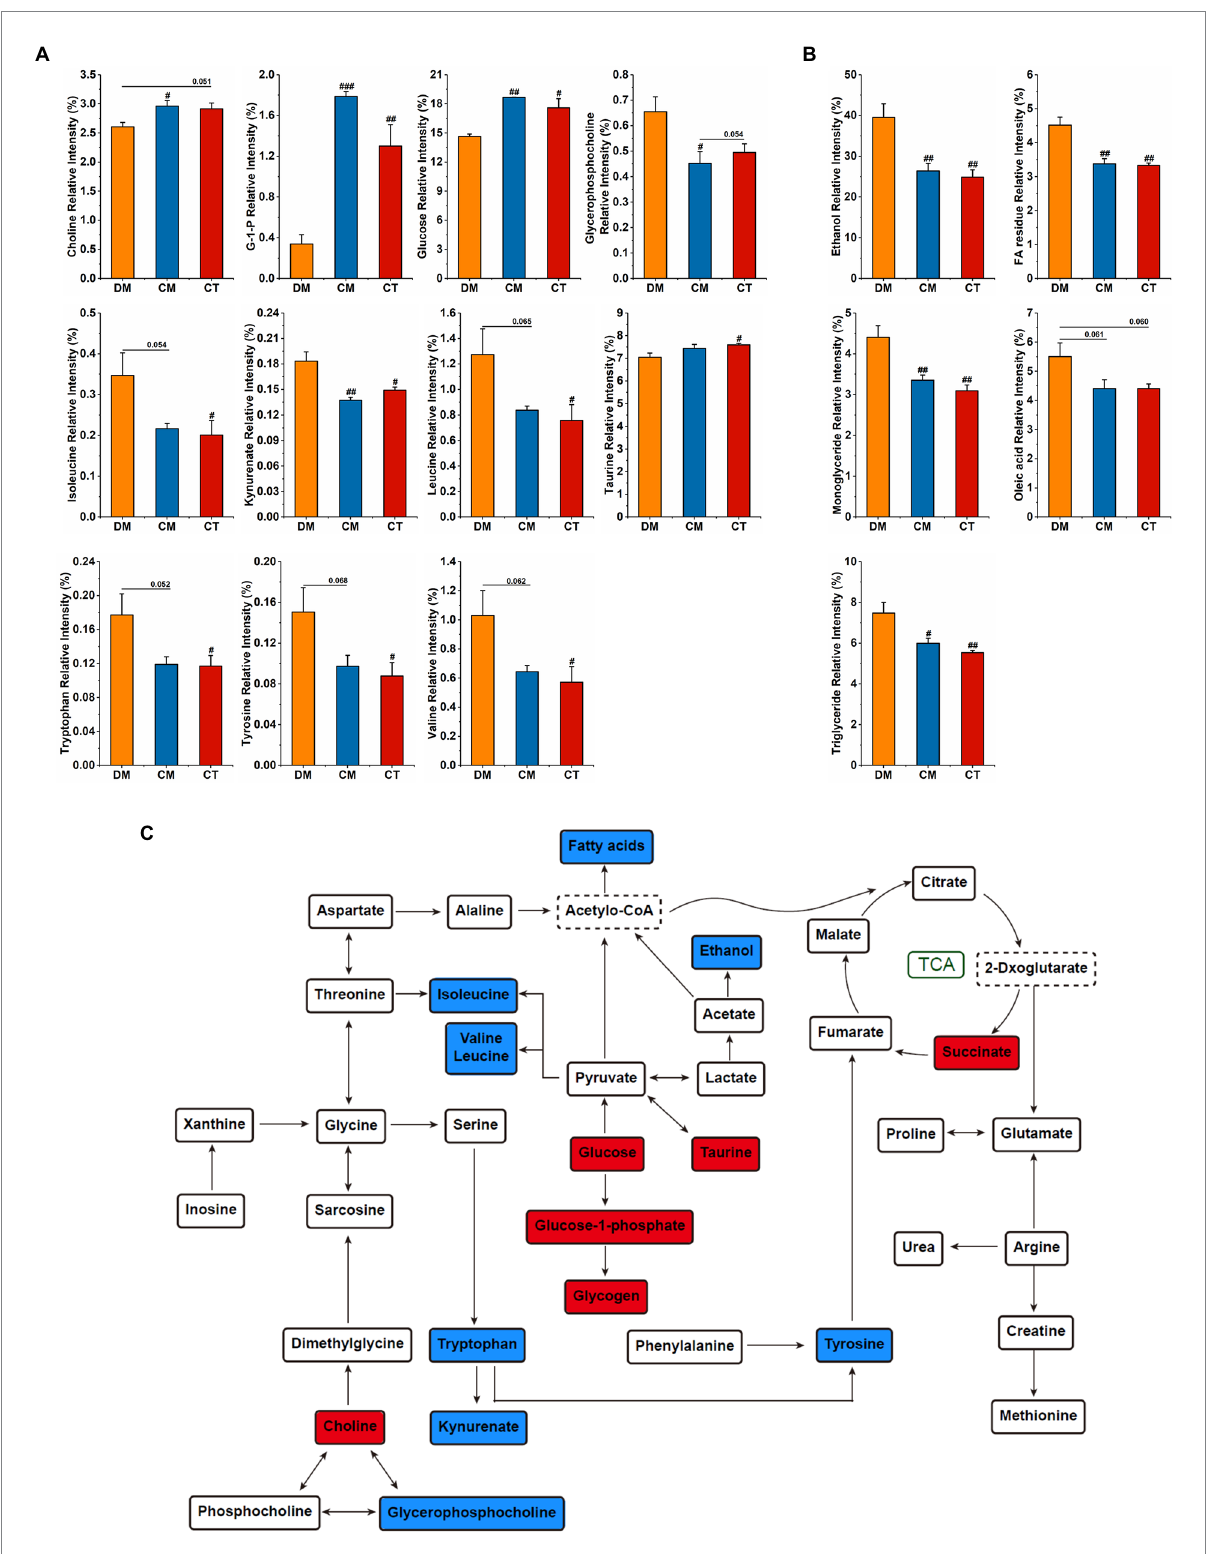
FIGURE 6 Supplementation with Christensenella affected liver metabolism. (A) Significant changes of relative intensity of hydrophilic metabolites. (B) Significant changes of relative intensity of lipophilic metabolites. (C) Main metabolite pathways of the liver of diabetic mice treated by Christensenella . The red/blue fillers indicate that the metabolite content increased/decreased after Christensenella treatment compared with the DM